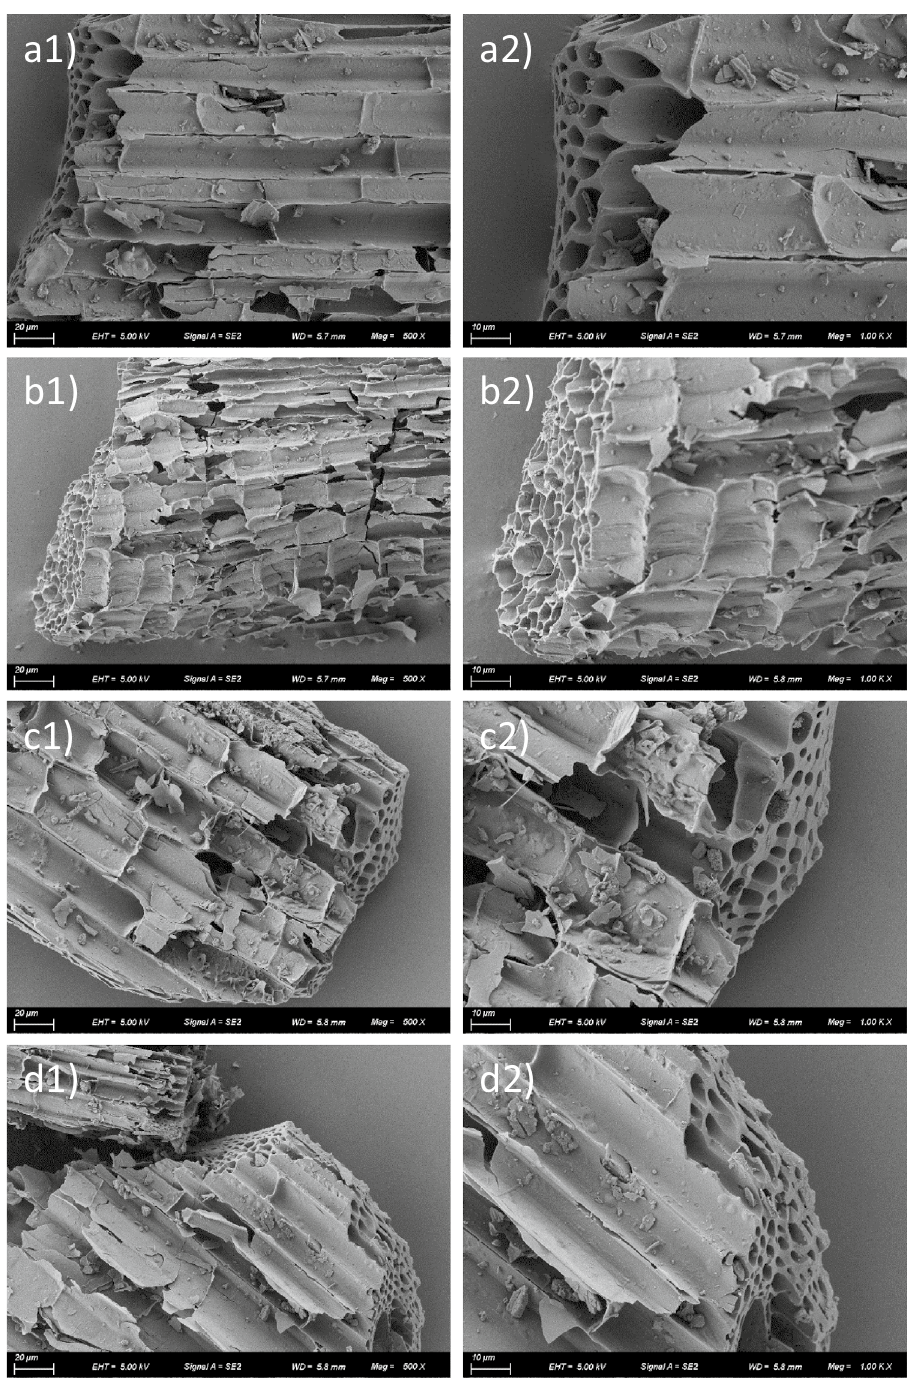
Figure 5. SEM images of the carbonized basal culms of ( a ) R1, ( b ) R2, ( c ) R3, and ( d ) R4. The ( a2 ), ( b2 ), ( c2 ), and ( d2 ) are the 2 times magnified images of ( a1 ), ( b1 ), ( c1 ), and ( d1 ), respectively. The scale has been shown at the lower part of each